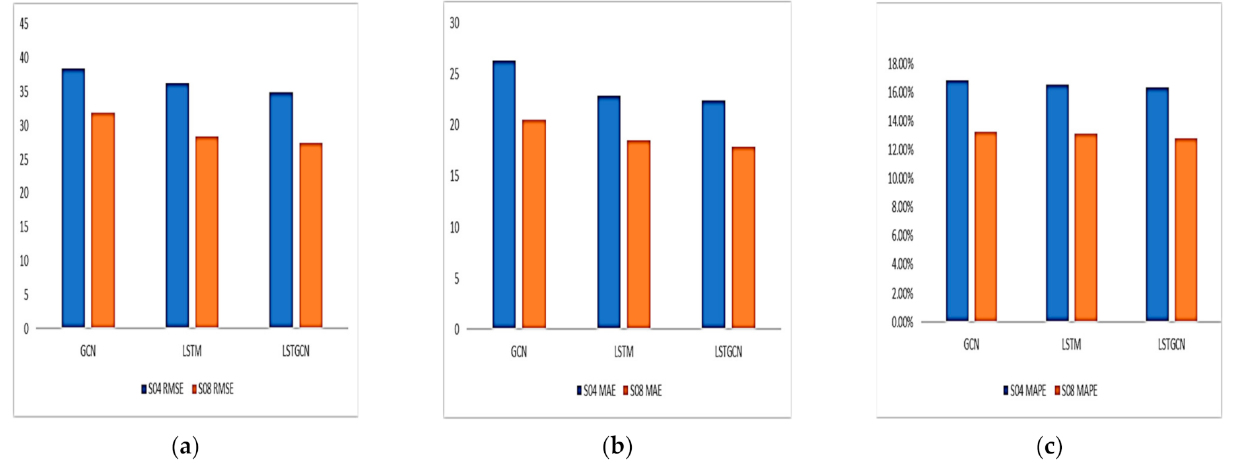
Figure 6. Average performance comparison of LST-GCN and GCN and LSTM on PEMS04 and PEMS08. ( a ) RMSE comparison of LST-GCN and GCN and LSTM on PEMS04 and PEMS08. ( b ) MAE comparison of LST-GCN and GCN and LSTM on PEMS04 and PEMS08. ( c ) MAPE comparison of LST-GCN and GCN and LSTM on PEMS04 and